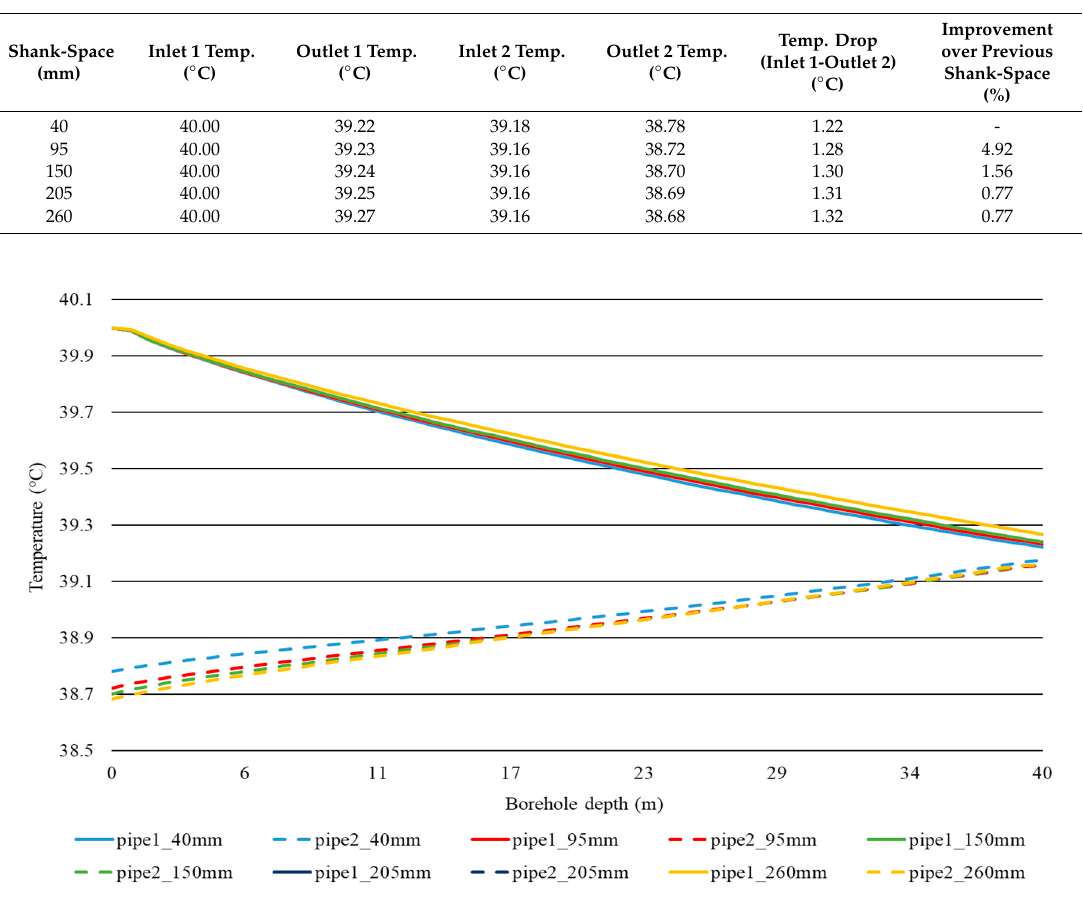
Table 3. Simulation results for different shank-spaces for the 40 m borehole.